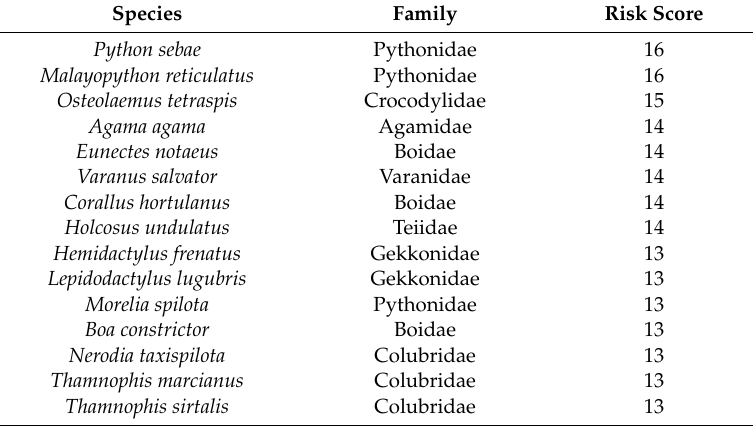
Table 2. Species of ornamental reptiles (excluding turtles) with highest potential to spread and negatively influence nature in the EU, based on AS-ISK (from the Biology / Ecology section